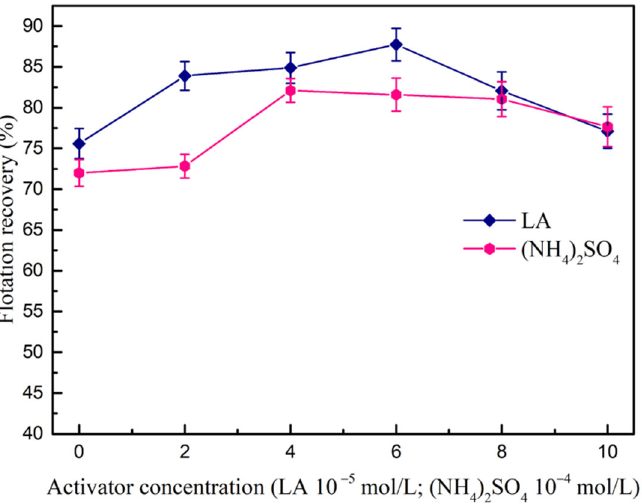
Figure 4. Flotation recovery of malachite as a function of LA and (NH 4 ) 2 SO 4 dosage ( c (BX) = 1.0 × 10 − 4 mol/L; c (Na 2 S) = 3.0 × 10 − 3 mol/L; pH = 9.6).